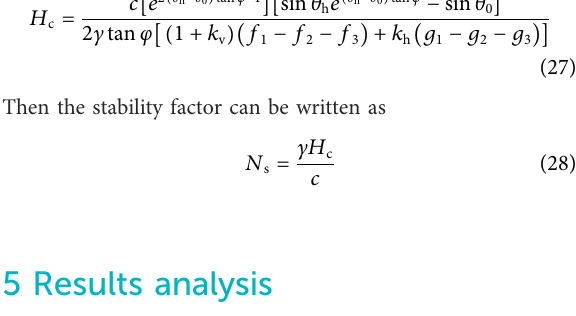
TABLE 2 Stability factor under the in fl uence of parameter b ( ζ =0.5,